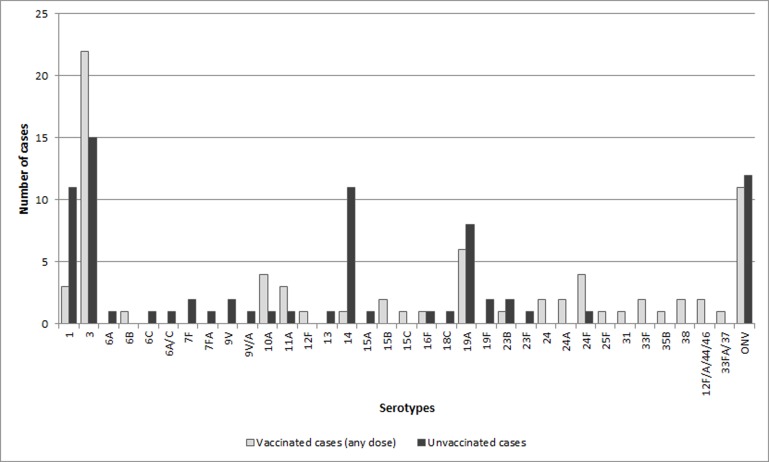
Distribution of serotypes of cases included in the study according to the receipt of any dose of PCV13 vaccinea.ONV = Other non-PCV13 serotypes aAny child who received only PCV7 or PCV10 was excluded